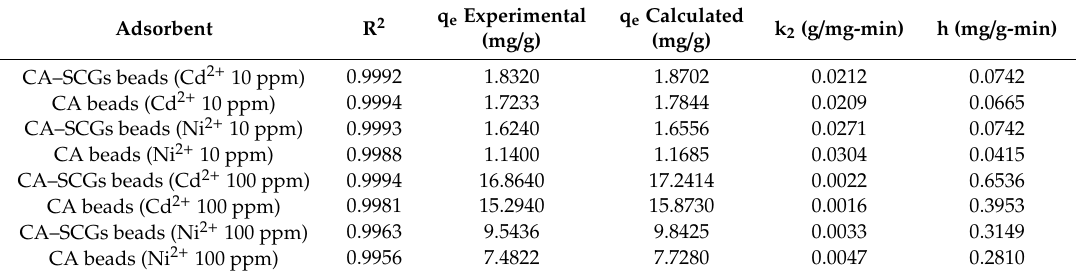
Table 5. Adsorption kinetic